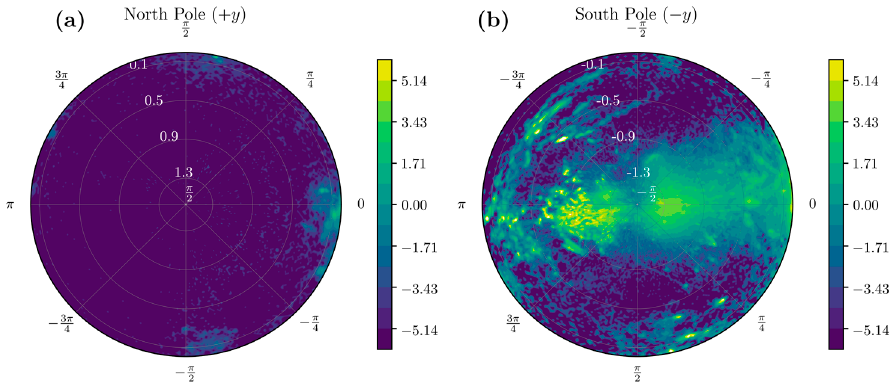
Figure 3. A visual representation of acceleration data from 3 days of continuous sensor wearing (25.92 million data samples) for a healthy participant projected onto the ( a ) upper and ( b ) lower hemispheres of the unit g acceleration sphere (UAS) when viewed along the y-axis. The color bars represent the log of the probability density of the projection of the acceleration onto the UAS.